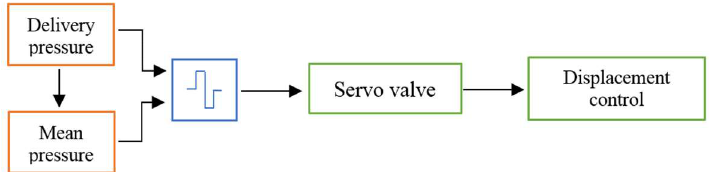
Figure 10. Scheme of the control strategy adopted for moving the pump swash plate.